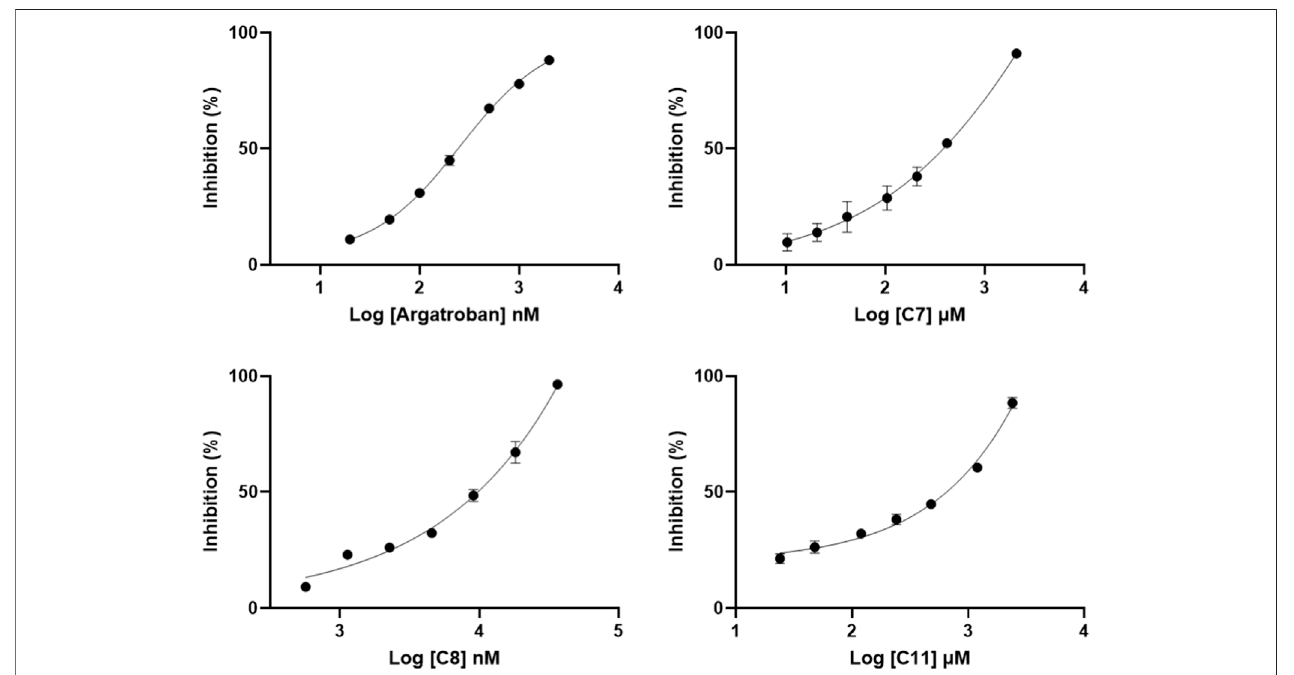
FIGURE 3 | Dose-response curves of in vitro inhibition